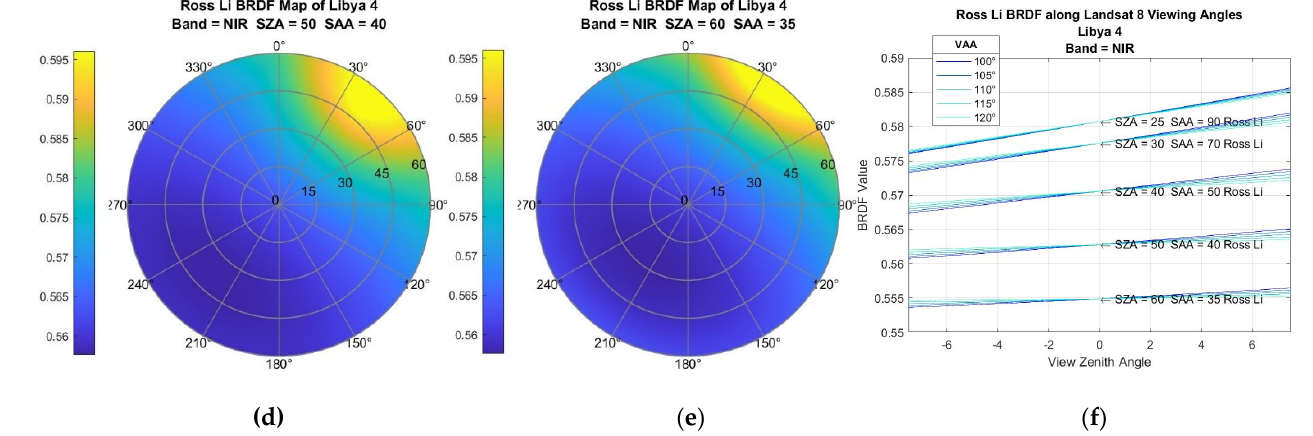
Figure 5. ( a – e ): BRDF models of Libya 4 calibration site for different SZA and SAA locations. Note how hot spot continues to follow solar location, but is more condensed than the previous figure. ( f ): Linearity of BRDF versus VZA for entire range of Landsat viewing angles. Note these have a smaller slope when compared to the previous figure.